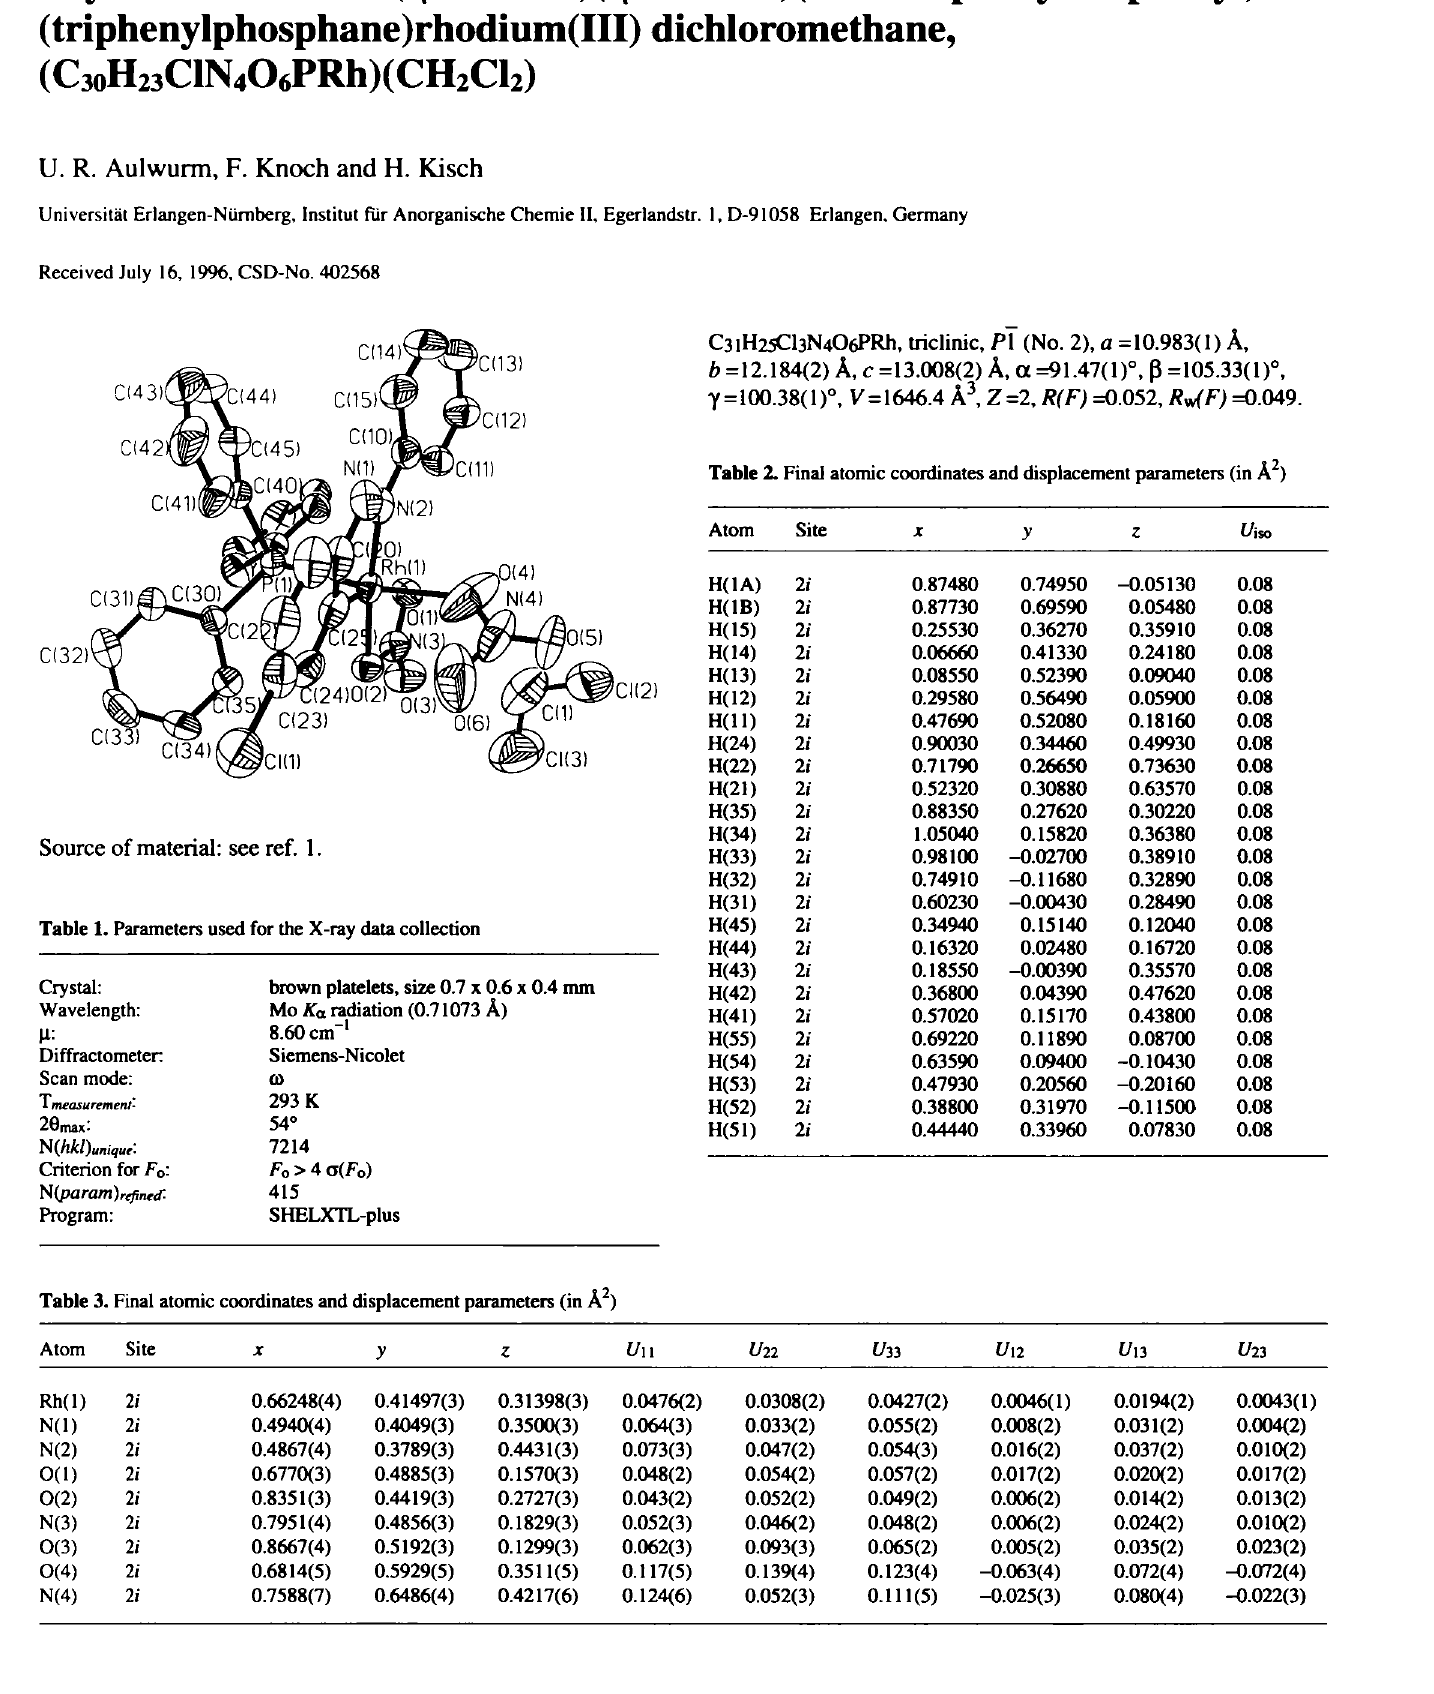
Table 2. Final atomic coordinates and displacement parameters (in Â 2 )